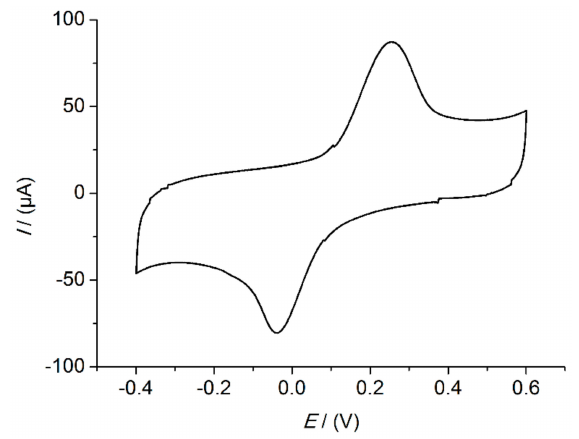
Figure A1. Cyclic voltammogram of SWCNT electrode with built-up immunosensor. Immunosensor on SWCNT electrode with 10 ng/mL of IL-13. Solution: 1 mM hydroquinone in 0.1 M PBS pH 6.0. Scan rate: 0.1 V/s.